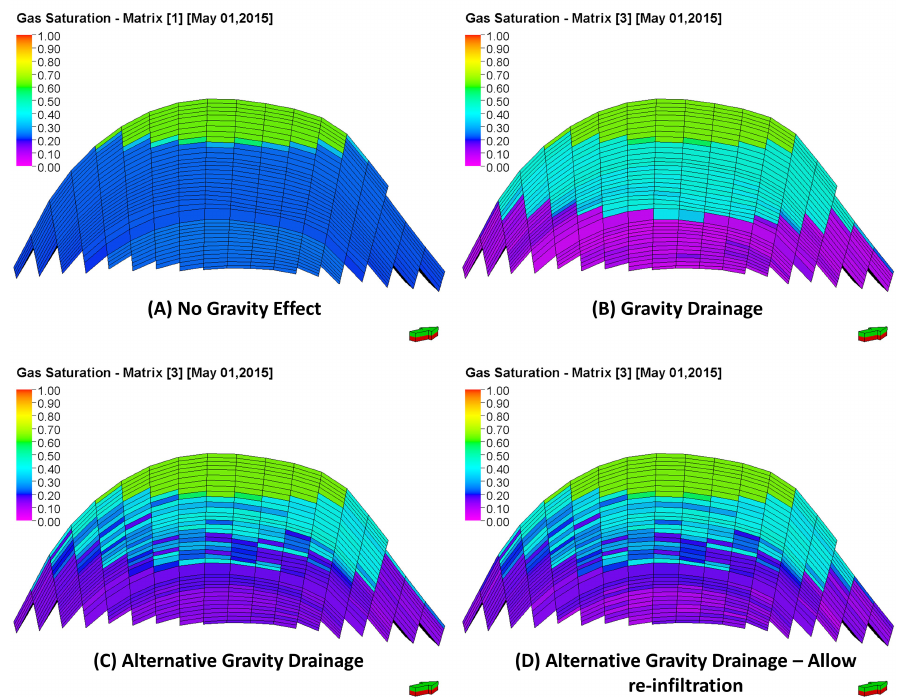
Figure 18. Comparison of the oil saturation profile using different formulas of gravity drainage; ( A ) No gravity effect, ( B ) Gravity drainage, ( C ) Alternative gravity drainage, and ( D ) Alternative gravity drainage–allow